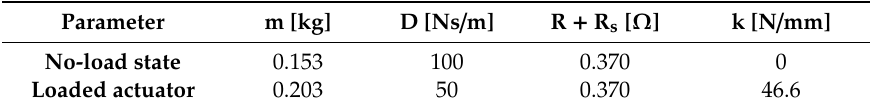
Table 2. Parameters of the transient model.